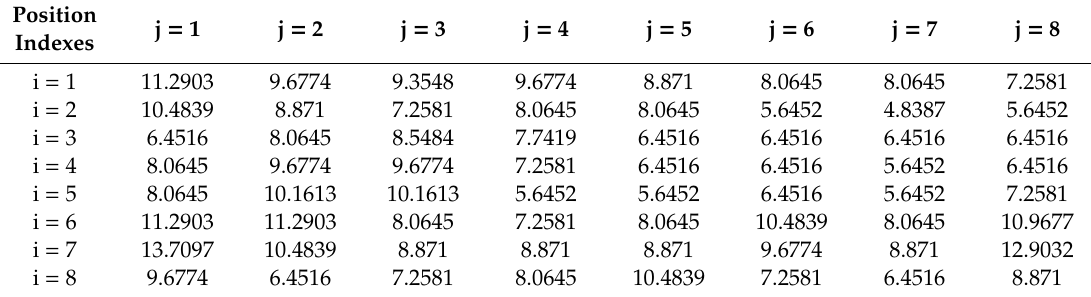
Table 3. Estimated strain (%) using a digital